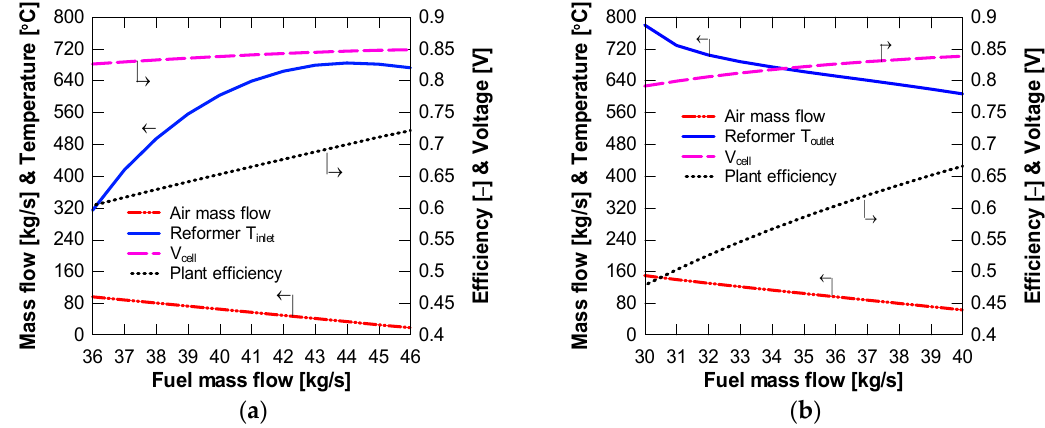
Figure 13. Effect of fuel mass flow on plant performance, ( a ) reformer outlet temperature is fixed and ( b ) reformer inlet temperature is fixed.